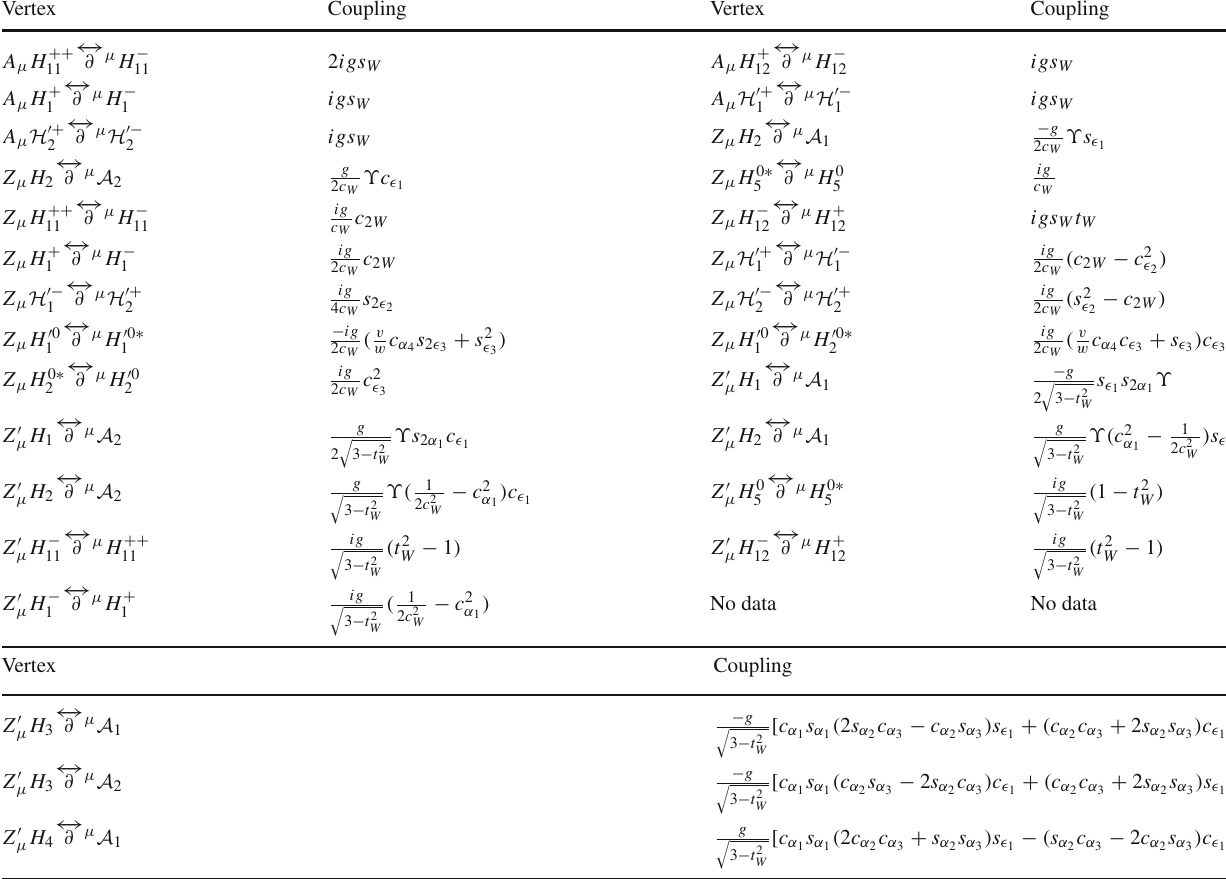
Table 3 The interactions of a neutral gauge boson with two scalars Vertex